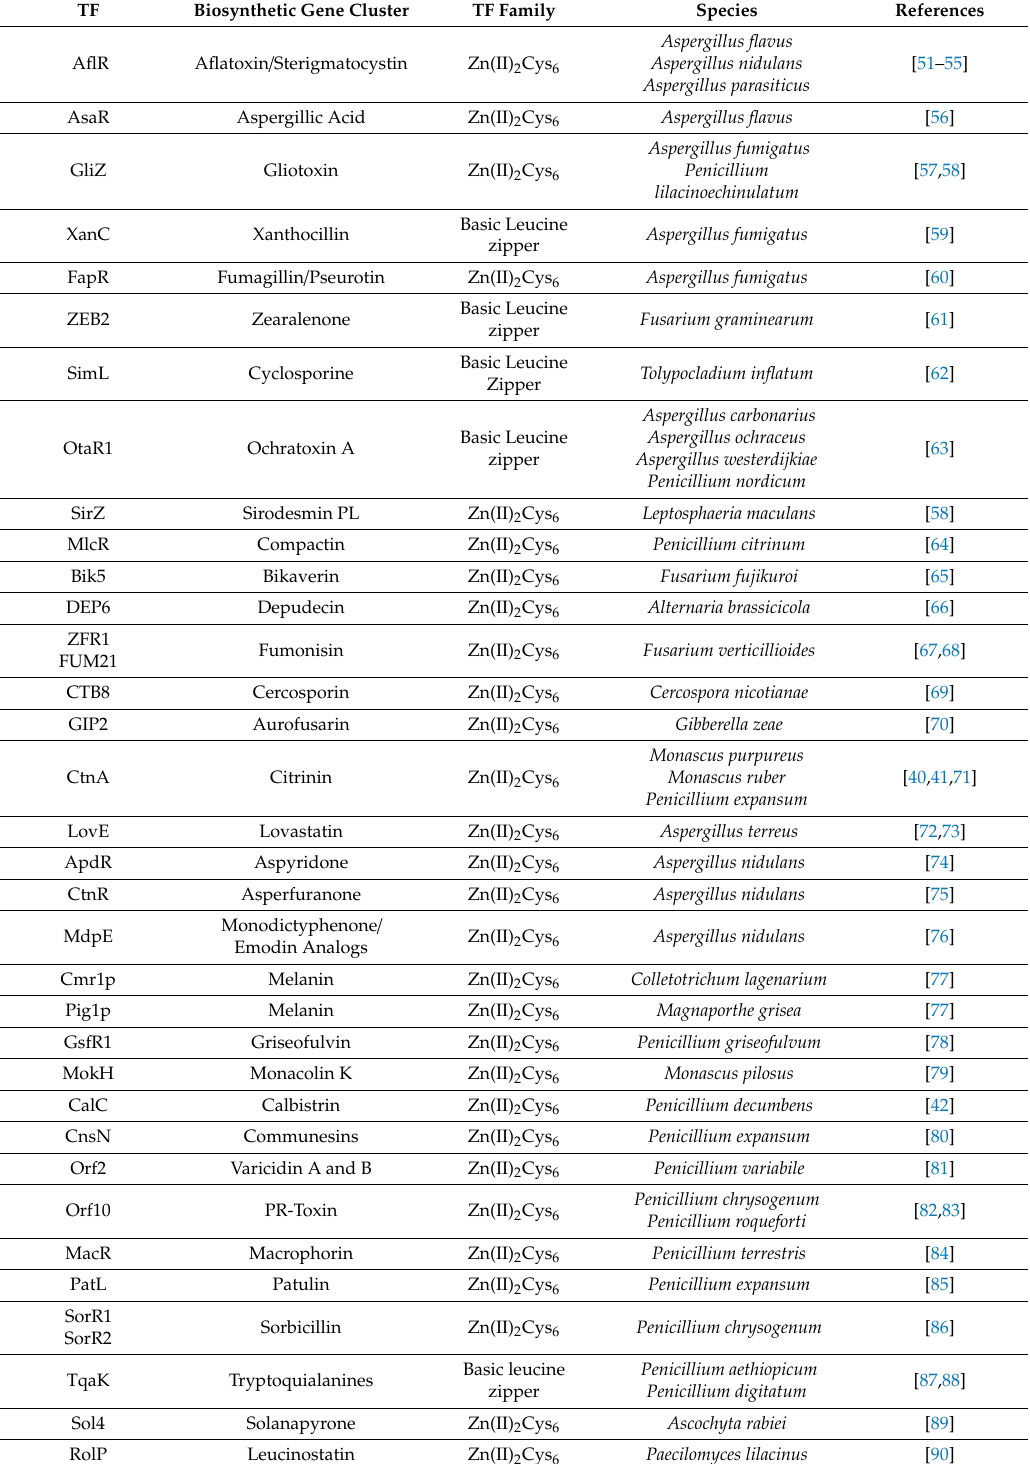
Table 1. Examples of identified Zn(II) 2 Cys 6 and leucine zipper transcription factor (TF) involvement in secondary metabolism in fungi; adapted and updated from Yin and Keller